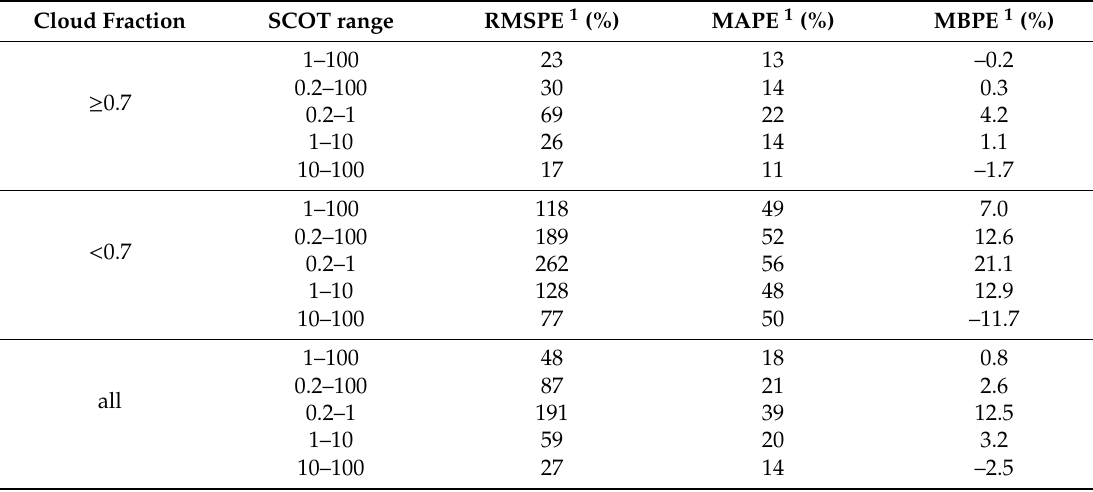
Table 2. Summary of errors in estimated slant-column COT (SCOT) along the line of sight from the simulated sky-view camera image, evaluated for the test data set. The results are summarized for di ff erent cloud fraction and SCOT ranges.